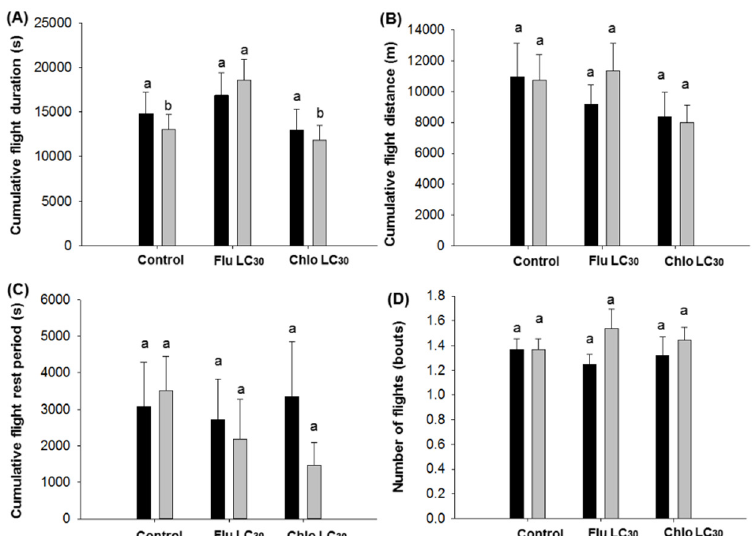
Figure 3. Chloridea virescens sustained flights greater than 30 min: ( A ) Cumulative flight duration, ( B ) cumulative flight distance, ( C ) cumulative flight rest period, and ( D ) number of flights (bouts). Black bars represent female and grey bars represent male moths. Di ff erent letters above the standard error bars indicate significant di ff erences based on Tukey–Kramer test ( p < 0.05).